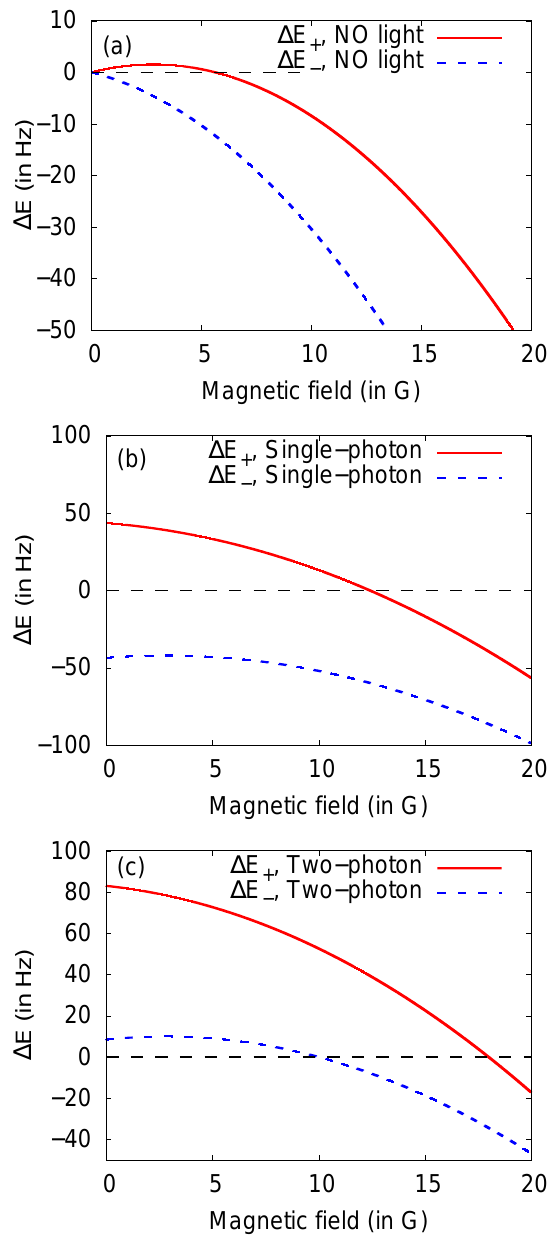
Figure 7. Magnetic energy diagram for the two heteronuclear spin-oscillation processes in the spin-1 137 Ba + and 87 Rb mixture ( a ) without light shift, ( b ) with light shift by single-photon interaction ( λ = 480.61 nm) and ( c ) with light shift by two-photon interaction (632.21 and 493.30 nm) and (533.08 and 423.14